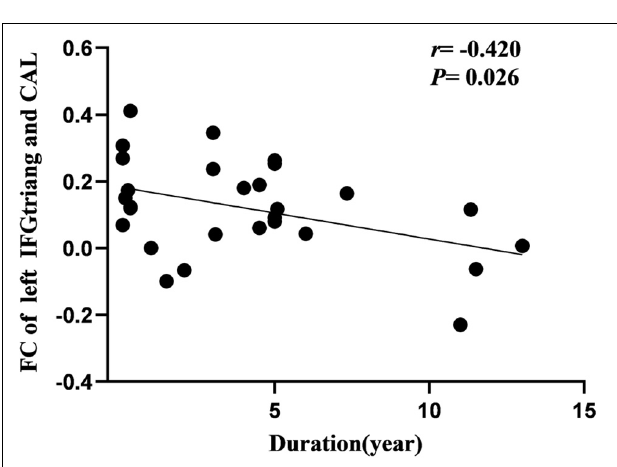
FIGURE 6 | Pearson correlation between FC of left CAL and course of disease in IGE patients. FC, functional connectivity; CAL, calcarine